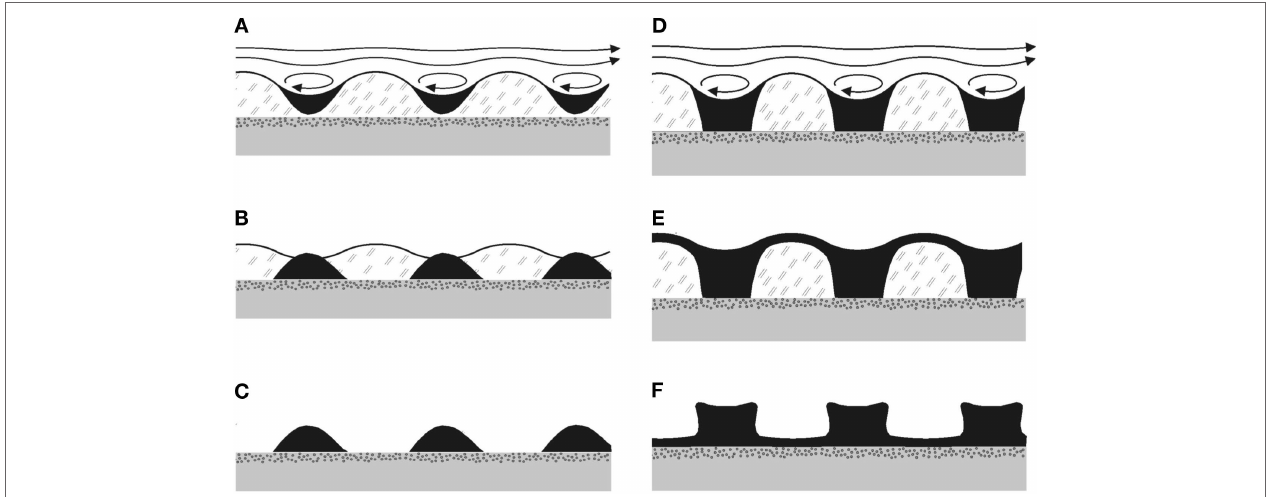
FIGURE 8 | Possible taphonomic sequences leading to Kinneyia fossils . (A–C) Sediment accumulates in the troughs of the ripple forming in the MM, and subsequently sinks down to the bedding plane due to gravity (B) . When the mat disintegrates, crests of sediment are left, which can fossilize subsequently. (D–F) Same mechanism as before, but with more sediment being deposited. As a consequence, there may finally (F) be connected crests, and various shapes of the slopes are